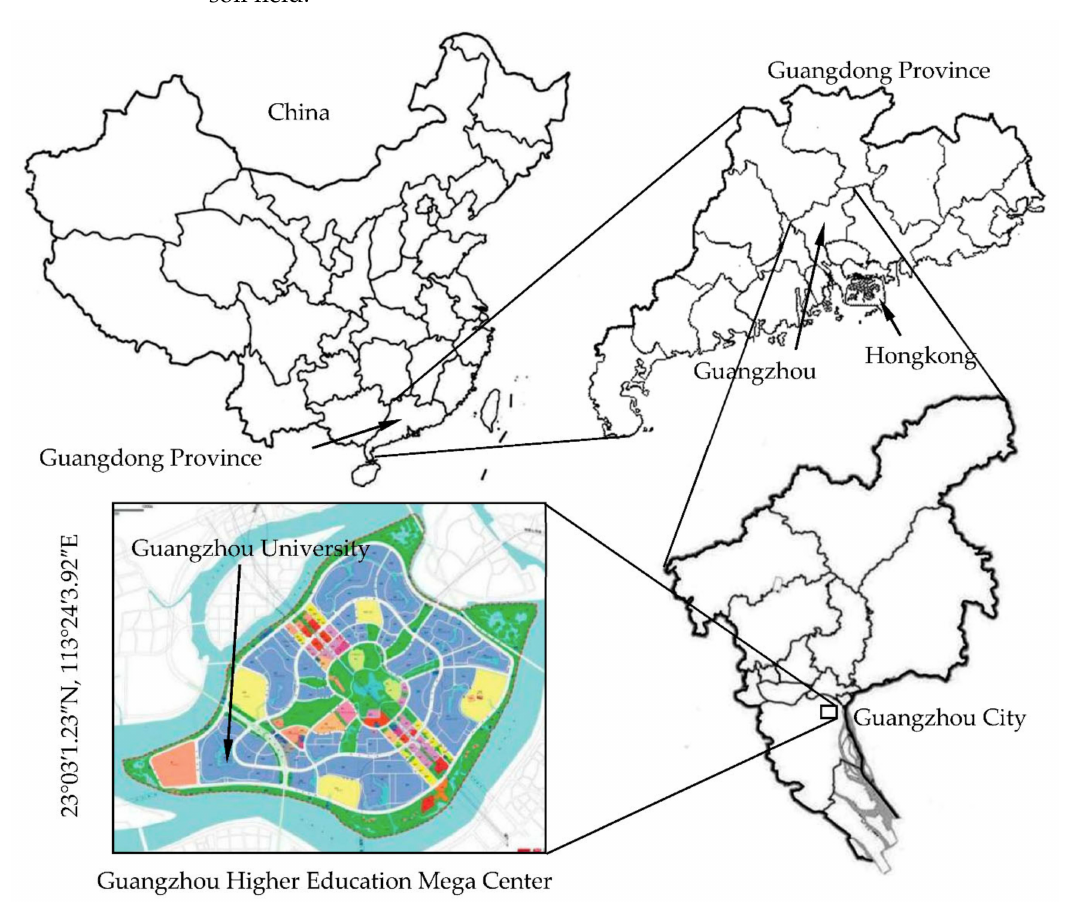
Figure 2. Location of Guangzhou University where sprinkler irrigation experiment was